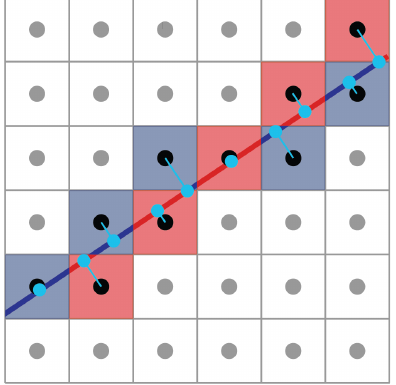
FIG. 8. Using the CPM to project a 2D square lattice to a 1D quasicrystalline chain. The solid line cuts the square lattice in an incommensurate direction. It is separated into small segments which belong to the unit cells it passes through (represented by red and blue colors). Each segment is mapped into the lattice site (black disks) associated with the unit cell it belongs to [according to the 1D version of Eq. (A1)]. These sites are then projected to the line, yielding the quasicrystalline 1D chain (cyan